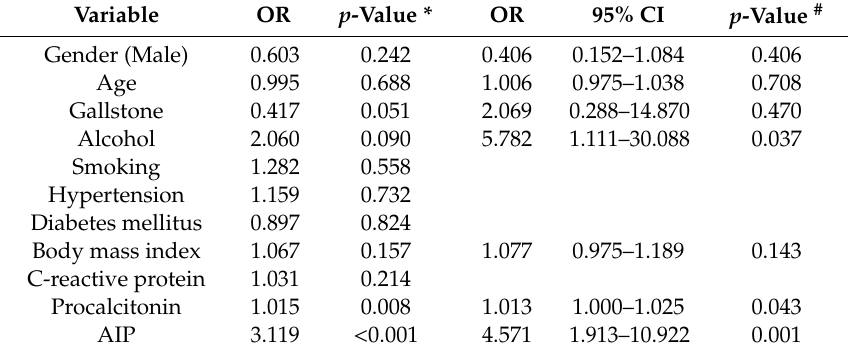
Table 4. The association between the AIP and severe acute